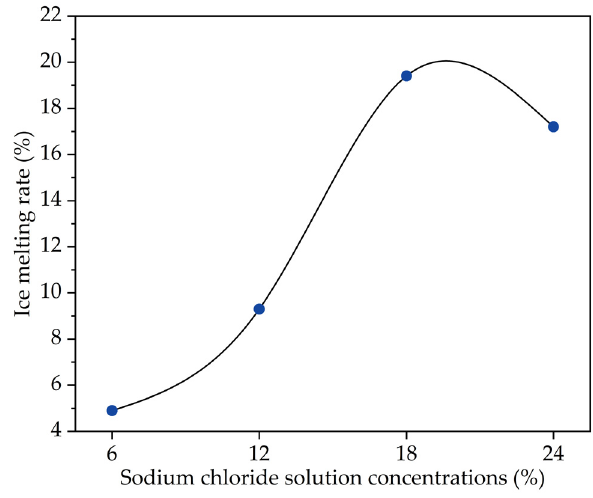
Figure 2. Snow melting ability of chloride salt solutions with concentrations.